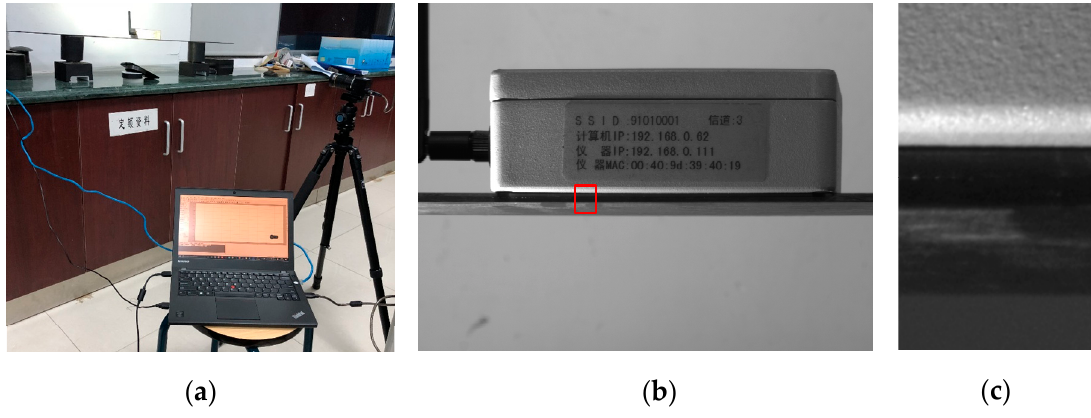
Figure 5. Laboratory experimental setup: ( a ) Camera, laptop, carbon plate, and vibrometer mounted at the midpoint; ( b ) Field of view of the camera (ROI highlighted in red rectangle); ( c ) ROI for vibration frequency measurement.